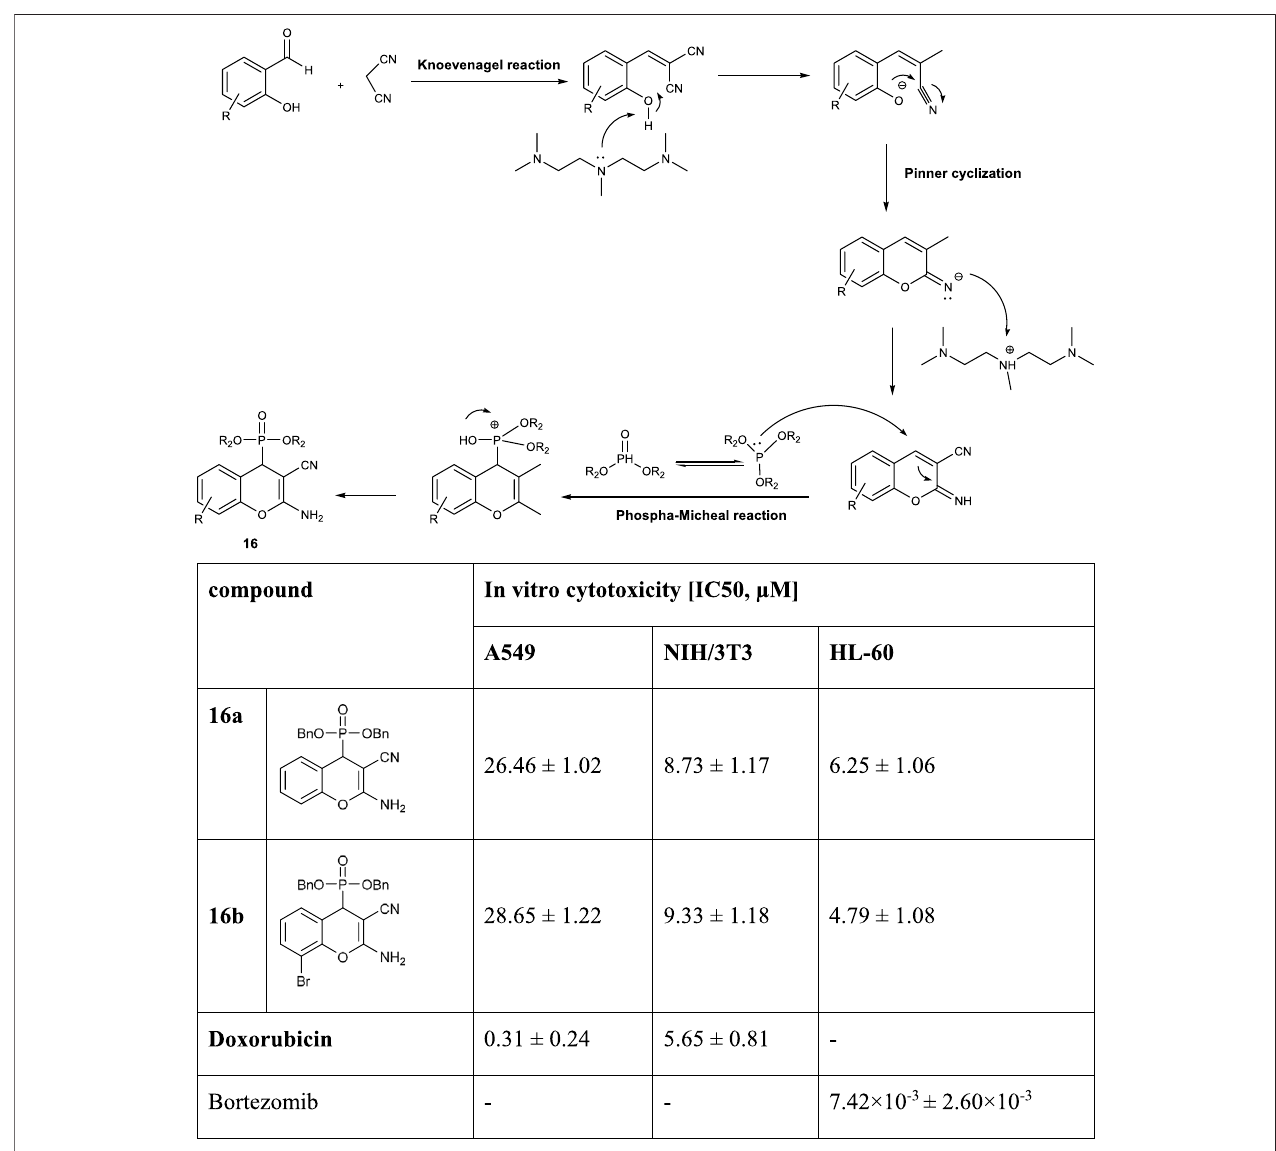
FIGURE 4 | Structures of the compound 16 and its biological